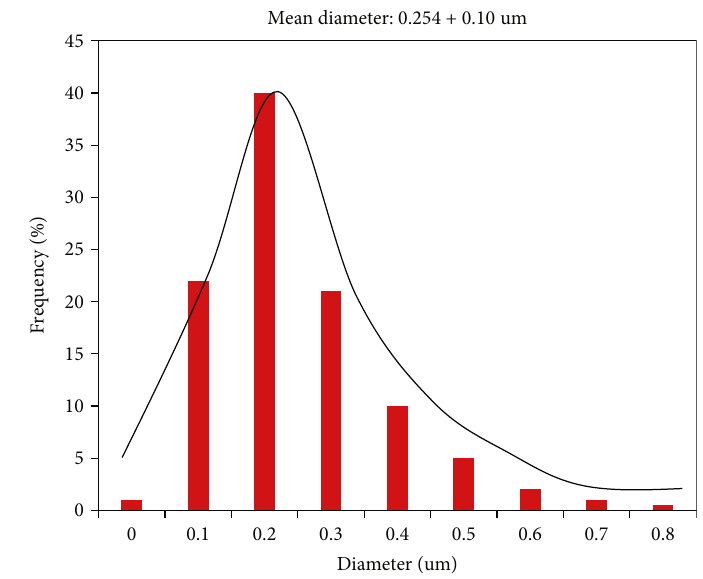
Figure 4: Size distribution of monomeric